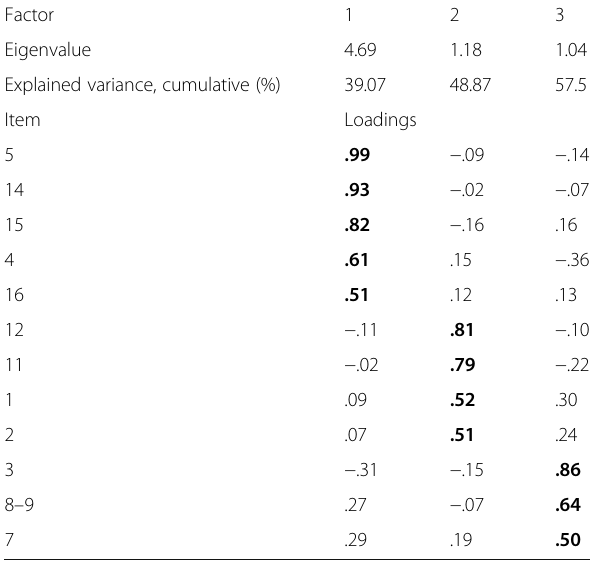
Table 8 Single Step Questionnaire: exploratory factor analysis